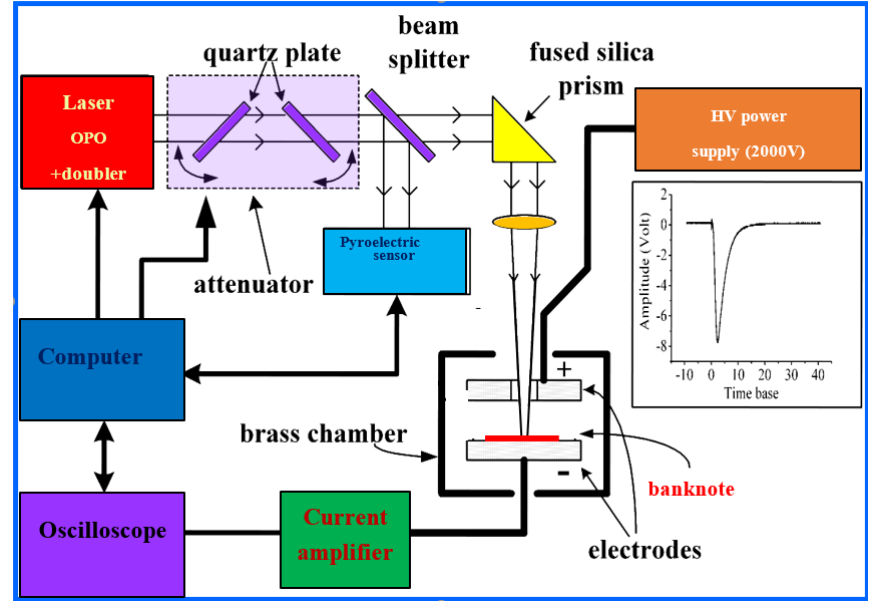
Figure 1. The experimental setup for measuring MEES